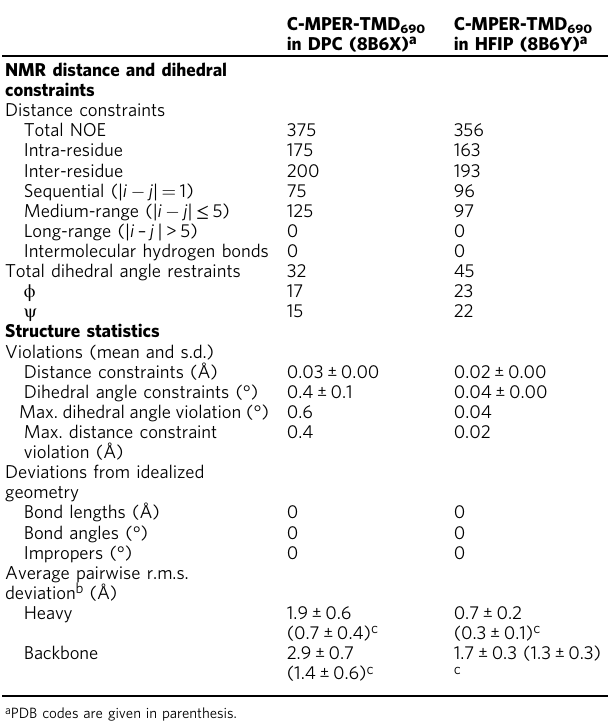
Table 1 NMR and re fi nement statistics for structure of C-MPER- TMD 690 in DPC (20 mM deuterated dodecylphosphocholine, 2mM HEPES pH 7.0, H 2 O/D 2 O 9:1 v/v) and HFIP (25% deuterated 1,1,1,3,3,3-hexa fl uoro-2-propanol in 2mM HEPES pH 7.0, H 2 O/D 2 O 9:1